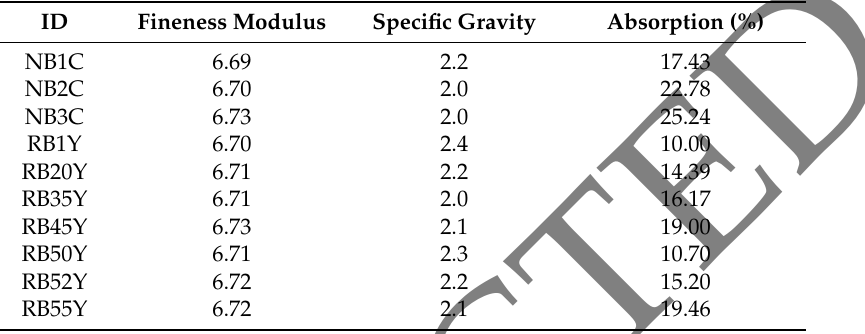
Table 1. Physical properties of different